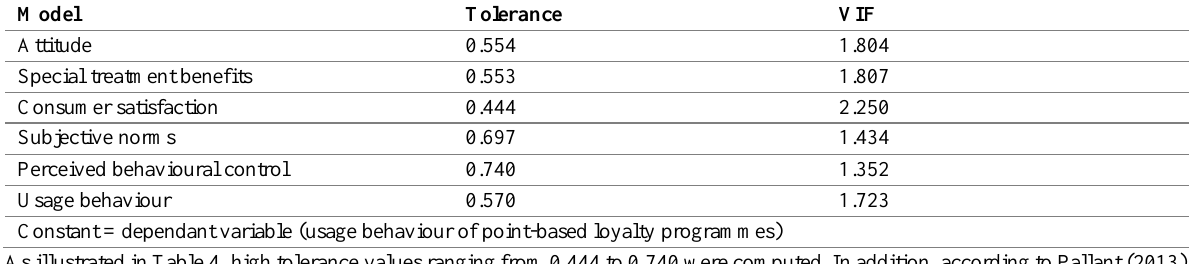
Table 4: Multicollinearity diagnostics of the data set